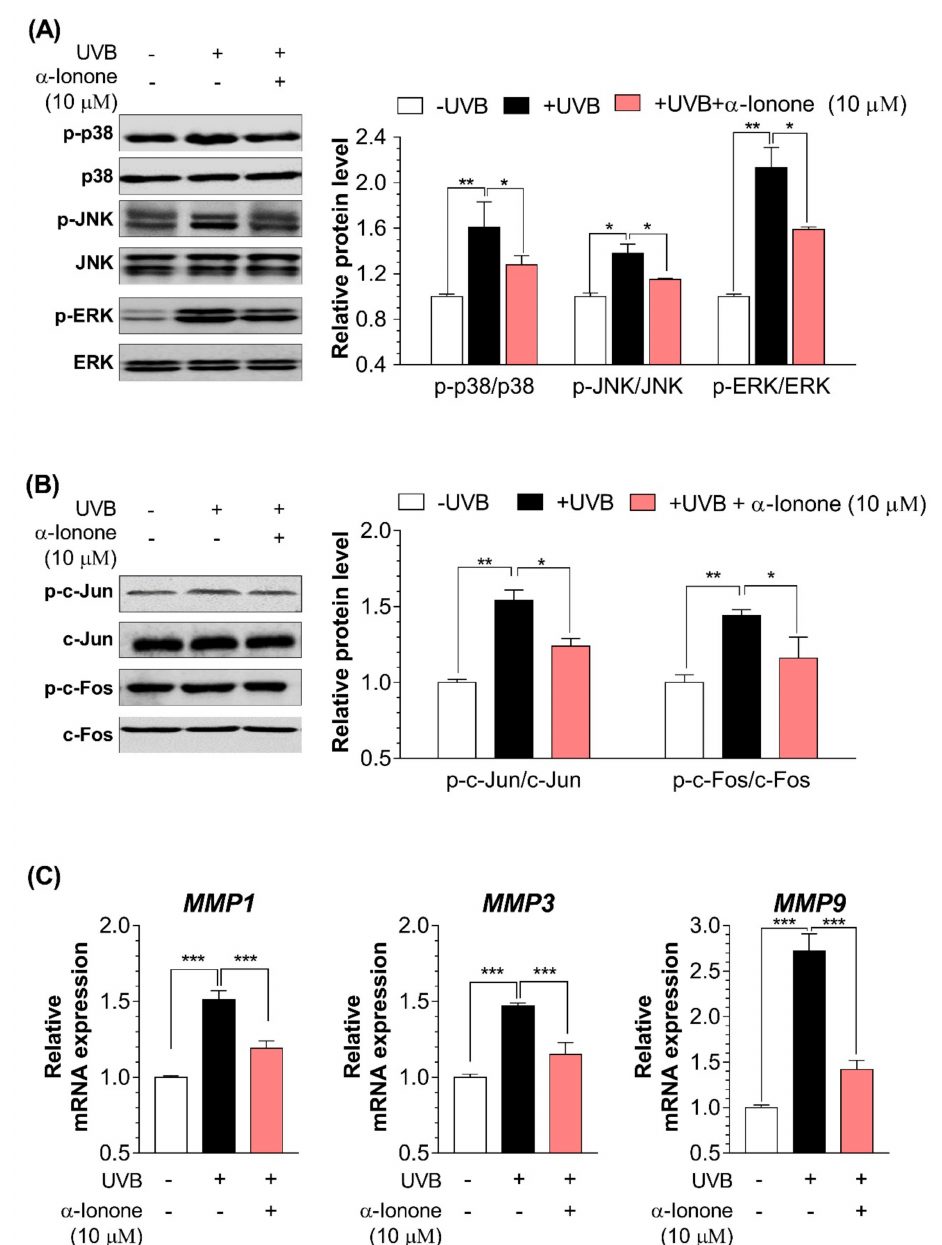
Figure 4. α -Ionone decreases the expression of molecules related to degradation in human Hs68 dermal fibroblasts. ( A ) Protein amounts of phospho-p38, p38, phospho-JNK (Jun N -terminal kinase), total JNK, phospho-ERK (extracellular signal-related kinase), and total ERK. ( B ) Protein expression of phospho-c-Jun, c-Jun, phospho-c-Fos, and c-Fos. ( C ) mRNA expression of MMP1 , MMP3 , and MMP9 . Values are presented as means ± SEM (n = 3). Significant di ff erences between groups are indicated by asterisks: * P < 0.05; ** P < 0.01; *** P <